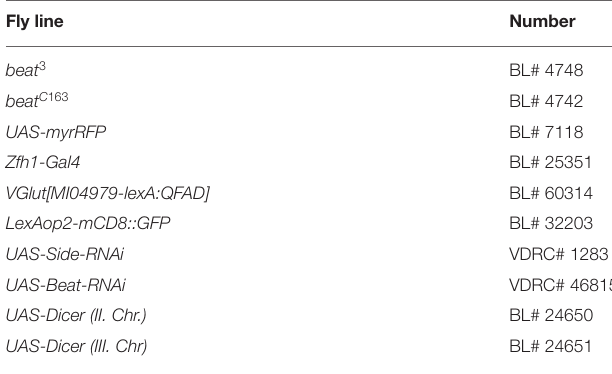
TABLE 1 | Used fly lines ordered from the Bloomington or VDRC stock